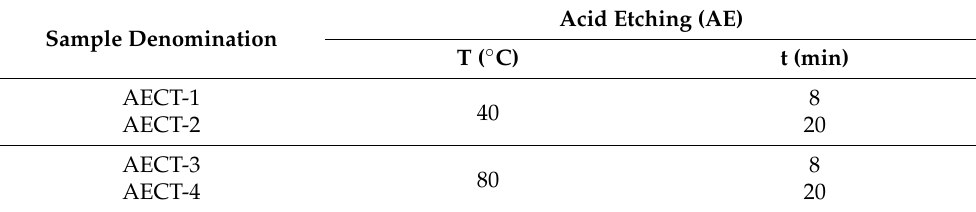
Figure 1. Schematic representation of the surface treatments used. SLM: selective laser melting. Table 1. Acid etching treatments. All samples were superficially modified with successive chemical oxidation treatment (at 80 °C for 30 min) and thermochemical treatment (at 400 °C for 1 h).